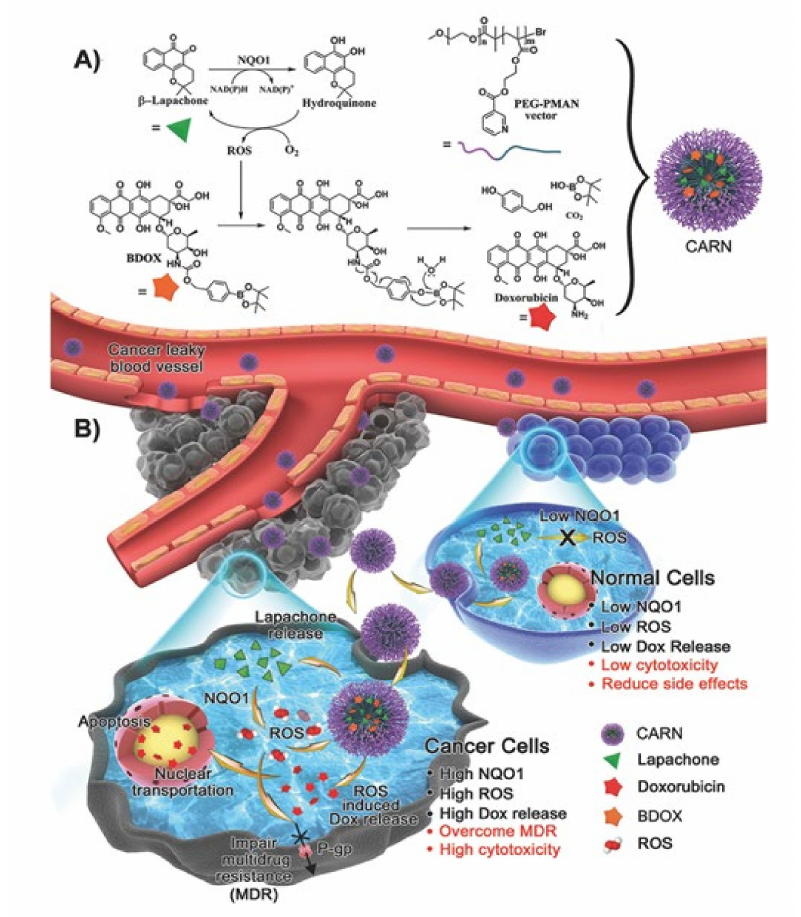
Figure 6. Cascade amplification release nanoparticle (CARN) formation process and its sequential release system. ( A ) Structure of BDOX, β -lapachone, and PEG-PMAN constituting CARN. ( B )